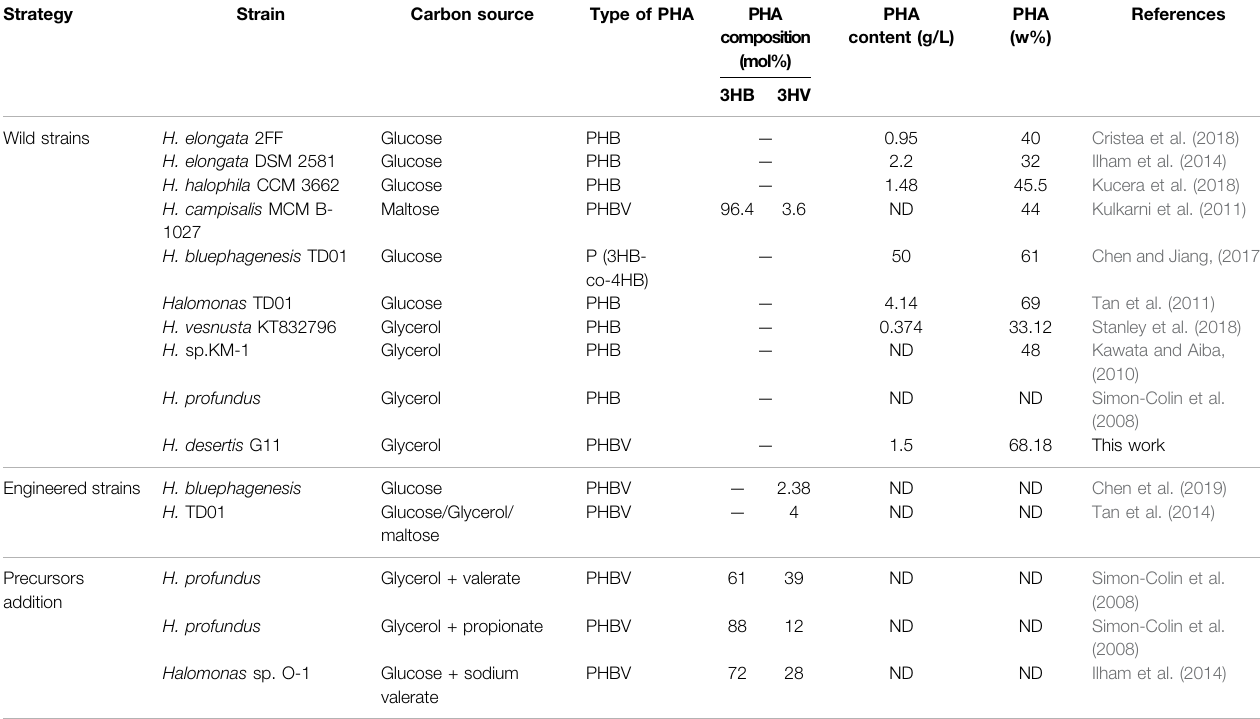
TABLE 2 | Production of PHA by halophilic or halotolerant Halomonas